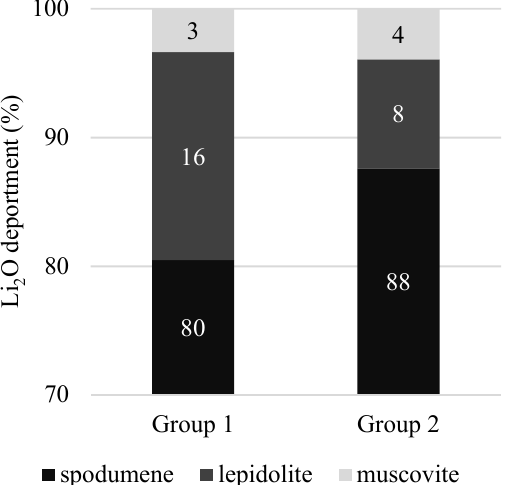
Figure 12. Li deportment in the total +0.037 mm interval.